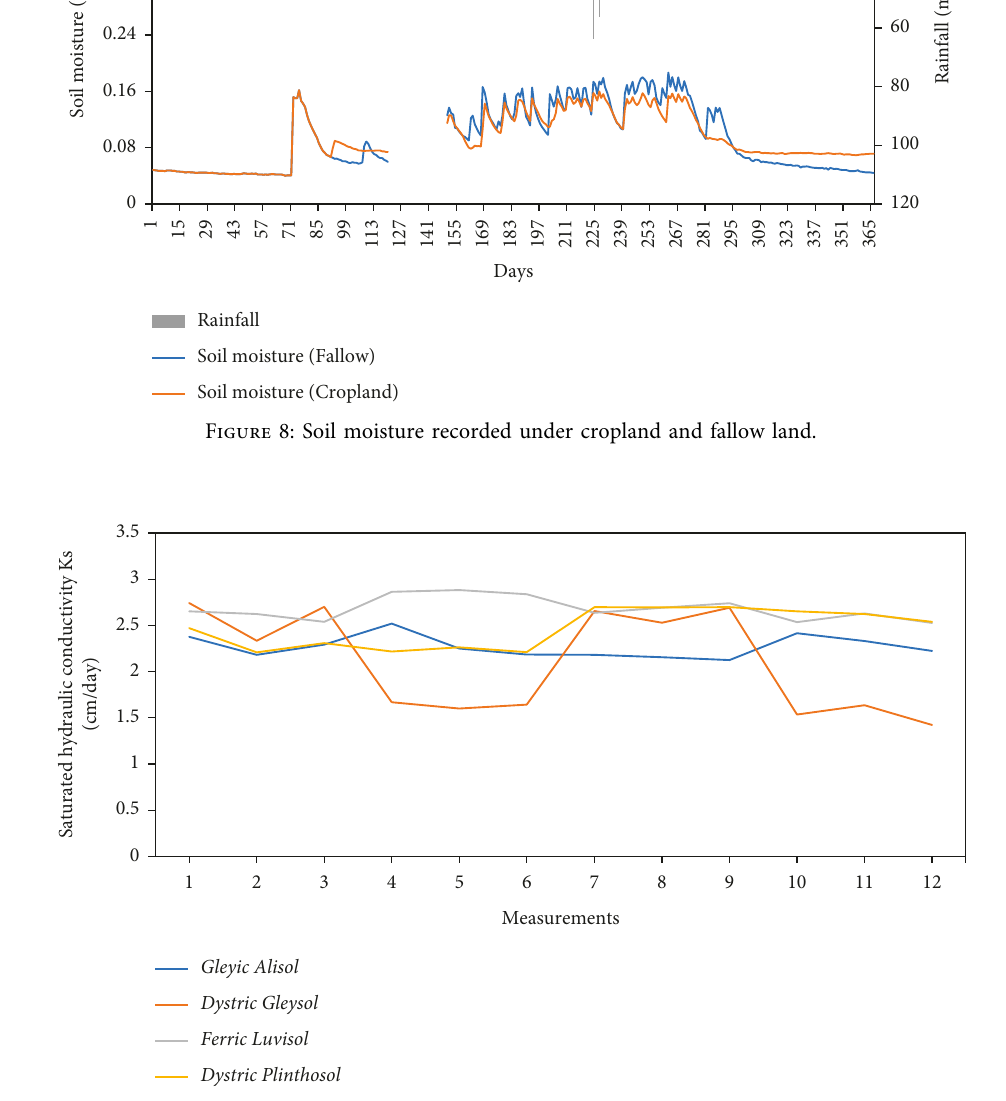
Figure 9: Saturated hydraulic conductivity under the soil classes of the watershed.